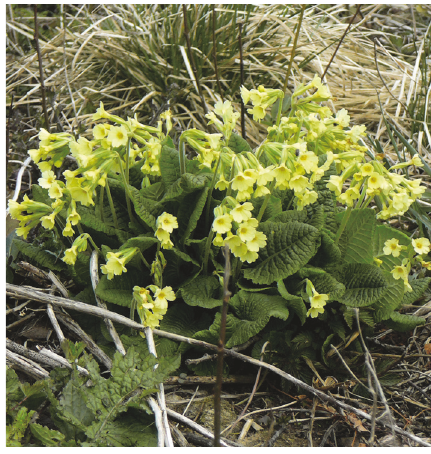
Figure 2: Oxlip (Primula elatior)